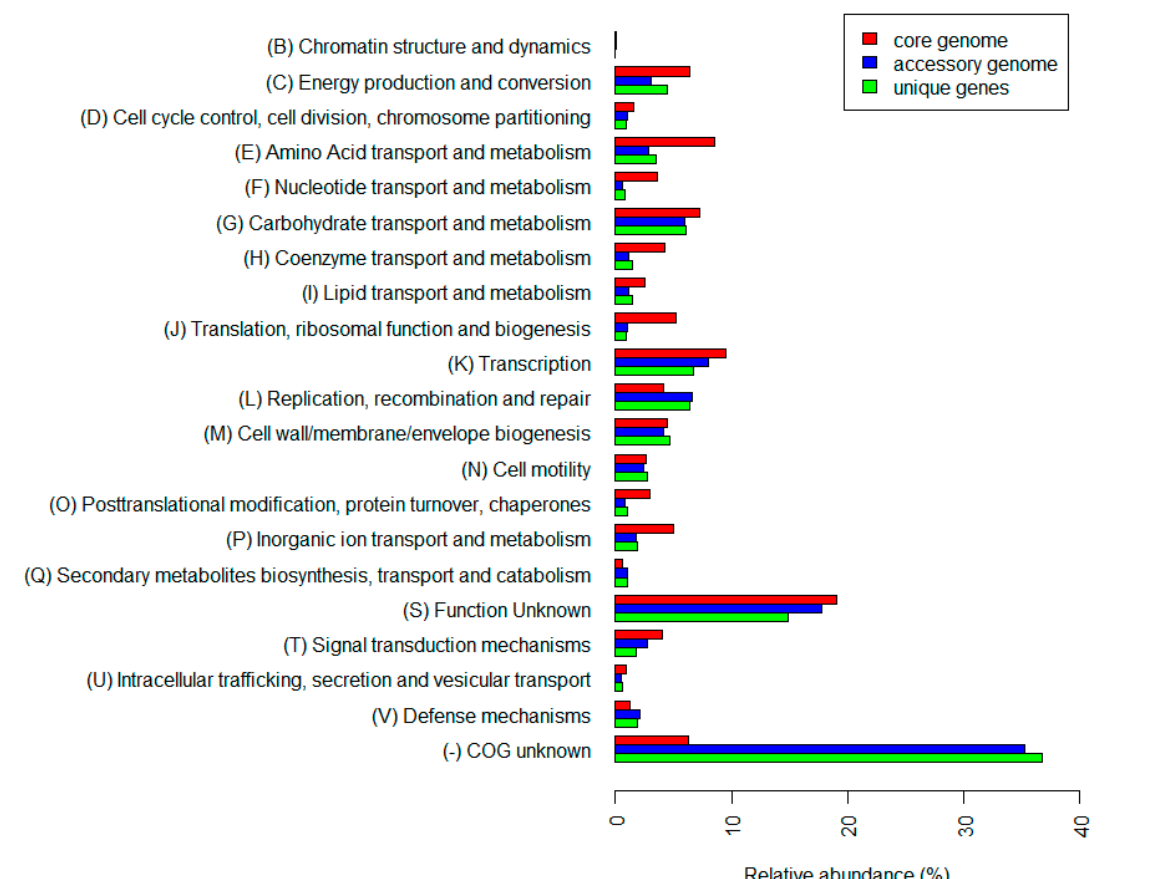
Figure 3. Relative abundances of genes in particular clusters of orthologous groups. Color coding distinguishes between gene from core (red) and accessory (blue) genomes and genes unique for particular strains (green).